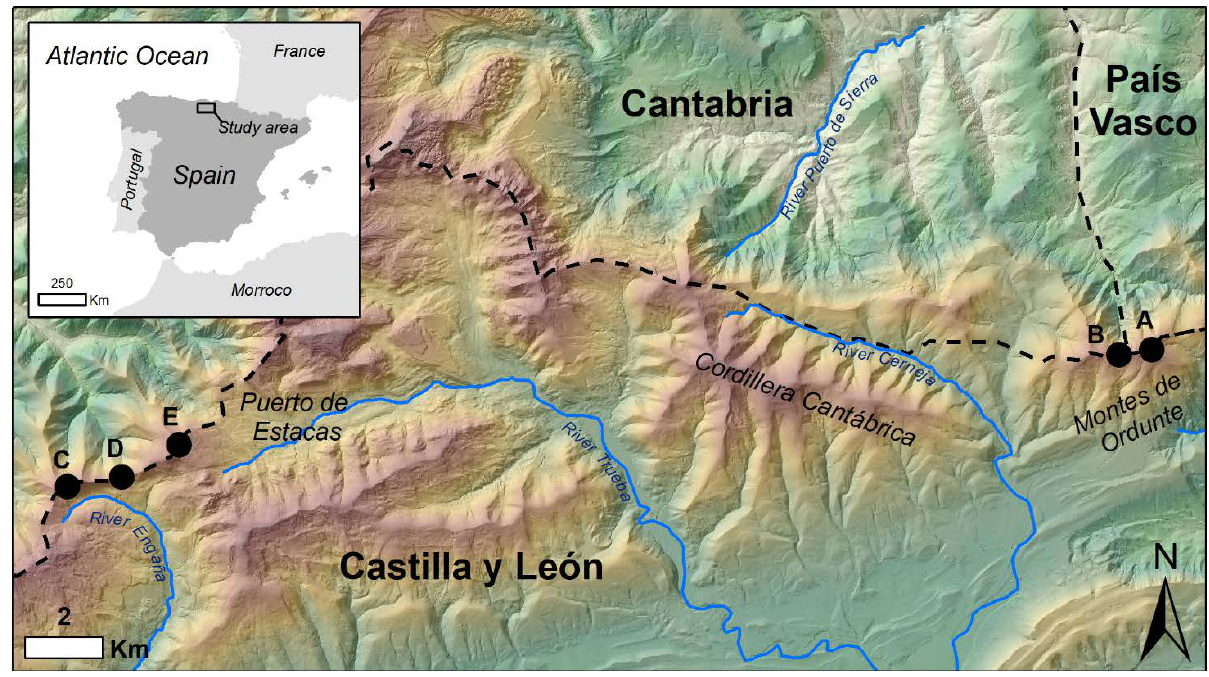
Figure 1. Location of study areas in Cantabria, Basque Country and Castilla y León administrative regions: A) Zalama; B) Ilsos de Zalama; C) La Marruya; D) Collado de Hornaza; E) Motas del